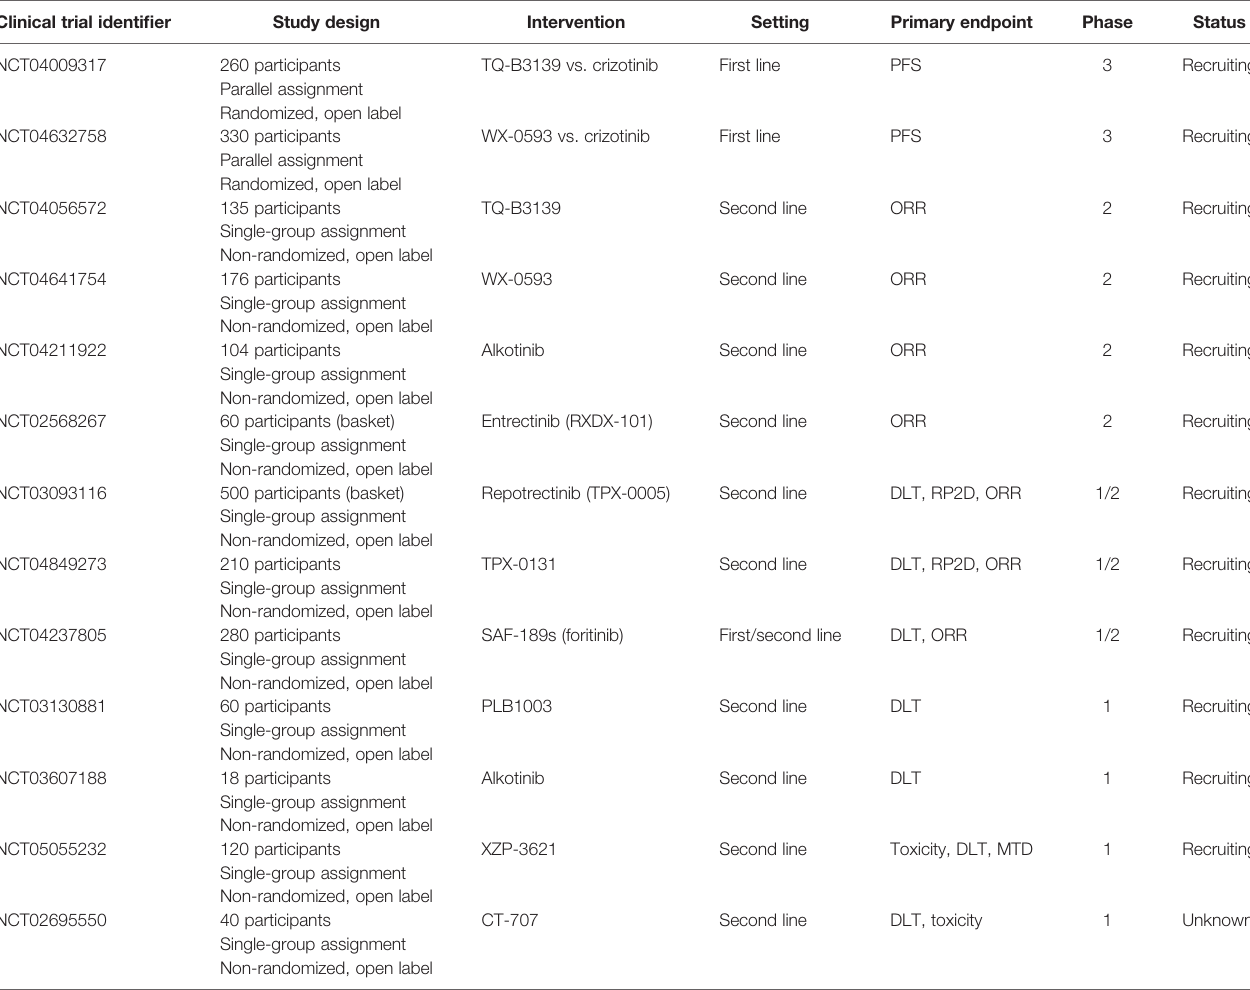
TABLE 2 | Ongoing clinical trials of novel ALK TKIs against ALK-arranged NSCLC. Clinical trial identi fi